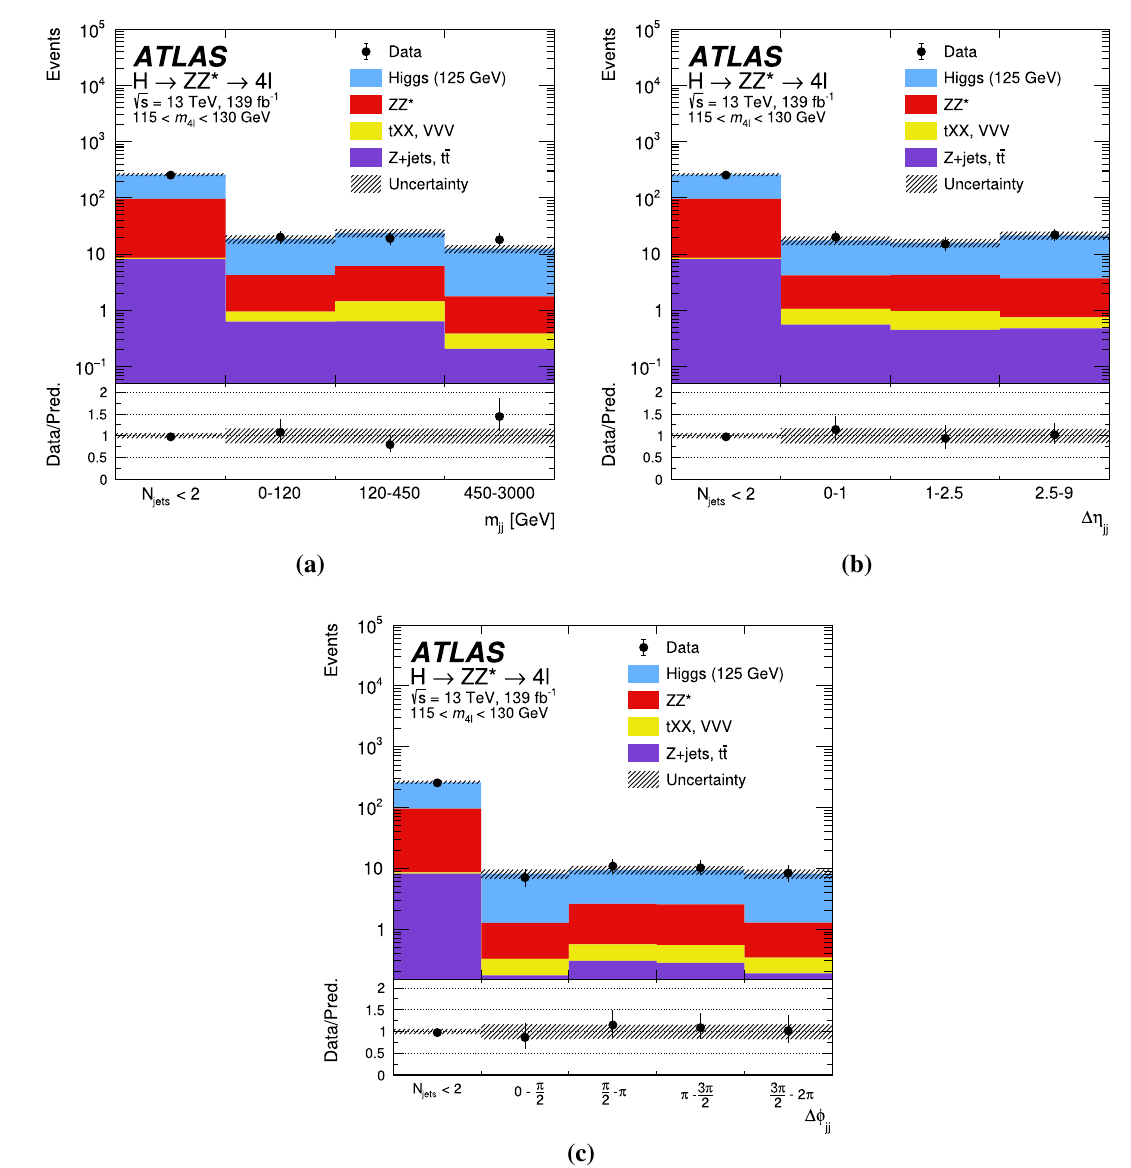
Fig. 8 The observed and expected (pre-fit) distributions of a m jj , b the first bin contains events with fewer than two jets. The uncertainty in (cid:9)η (cid:9)φ < m < 130 GeV, for an inte- the prediction is shown by the hatched band, which includes the theo- jj , and c jj in the mass region 115 4 (cid:3) √ retical uncertainties of the SM cross section for the signal and the Z Z ∗ s = 13 TeV. A SM Higgs grated luminosity of 139 fb − 1 collected at boson signalwithamass m H =125GeVisassumed. Inalldistributions,